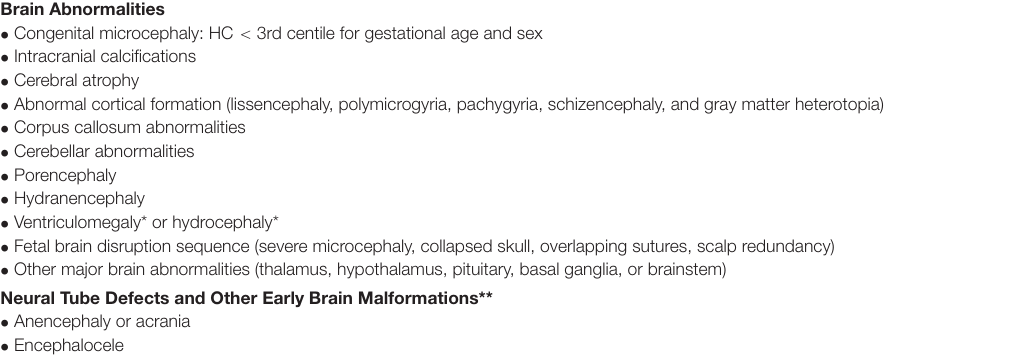
TABLE 3 | Congenital anomalies potentially related to maternal ZIKV infection.